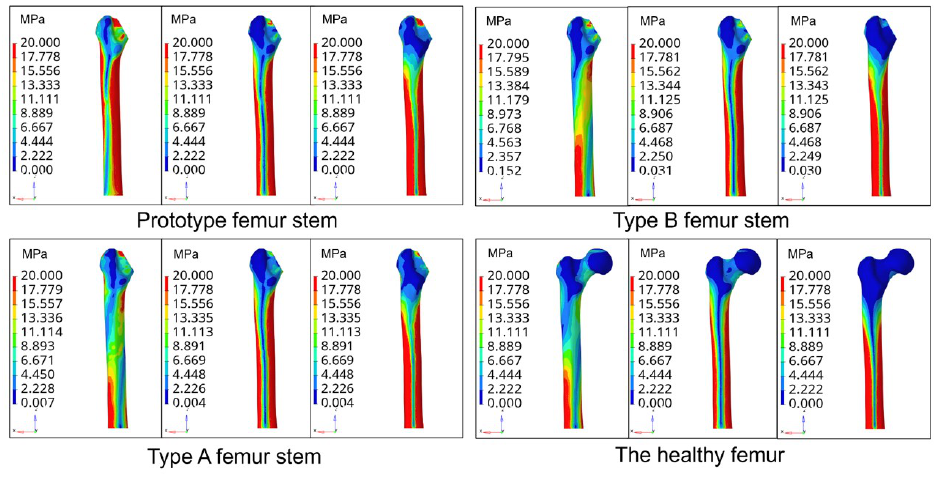
Figure 7. Stress nephogram of the femur stem under three